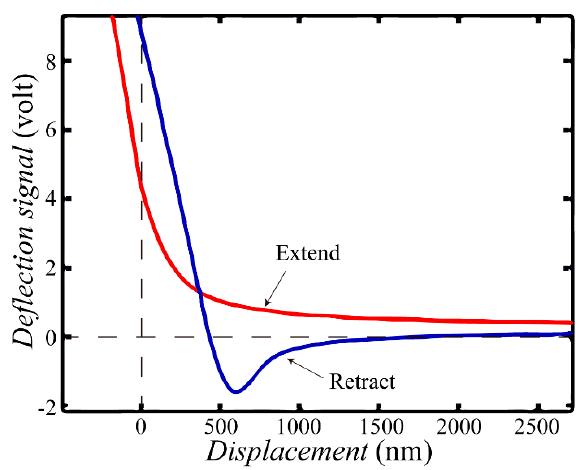
Figure 3. The original data of process and return curve at a velocity of 77 μ m/s